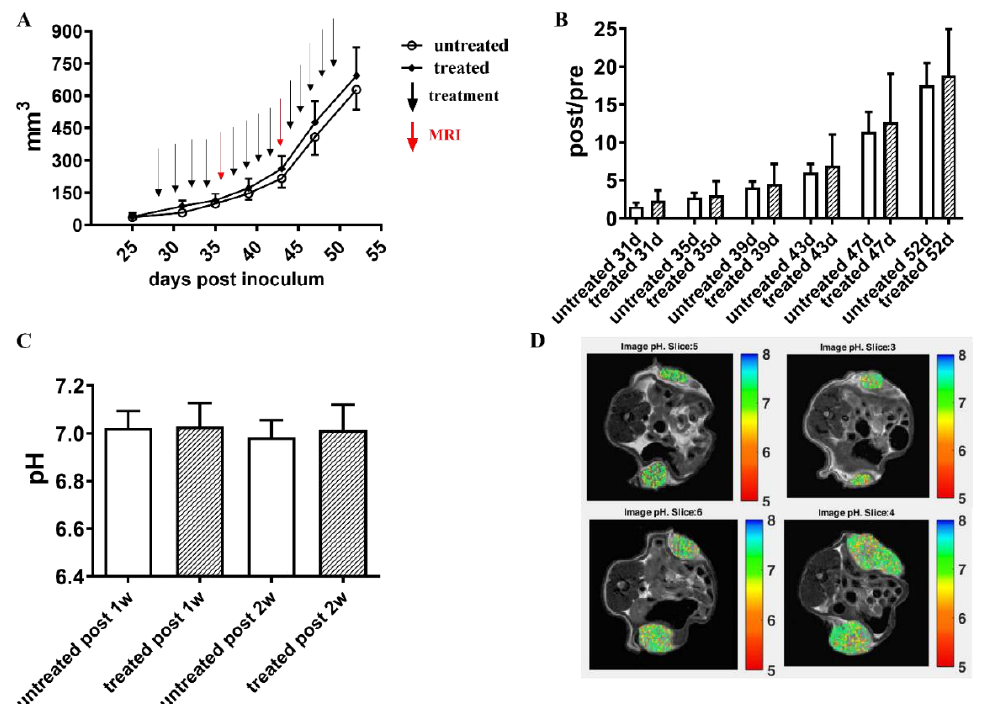
Figure 5. Long-term Esomeprazole treatment in the PC3 subcutaneous tumor model. Tumor growing curves obtained from caliper measurements ( A ). The black arrows indicate the day of intraperitoneal Esomeprazole administration (dose: 2.5 mg/kg b.w., every other day by gavage), whereas red arrows show MRI-CEST pH-imaging acquisitions. Column bar graph showing normalized tumor growth volumes, obtained by dividing the post-treatment volume measurements by the volumes measured on the day of mice randomization into the two groups ( B ). Extracellular tumor pH values between untreated (N = 8) and treated (N = 8) groups (white and pattern-filled, respectively, ( C )). Representative pH images of untreated and Esomeprazole-treated mice at one week (first row) and two weeks (second row) post-Esomeprazole treatment ( D